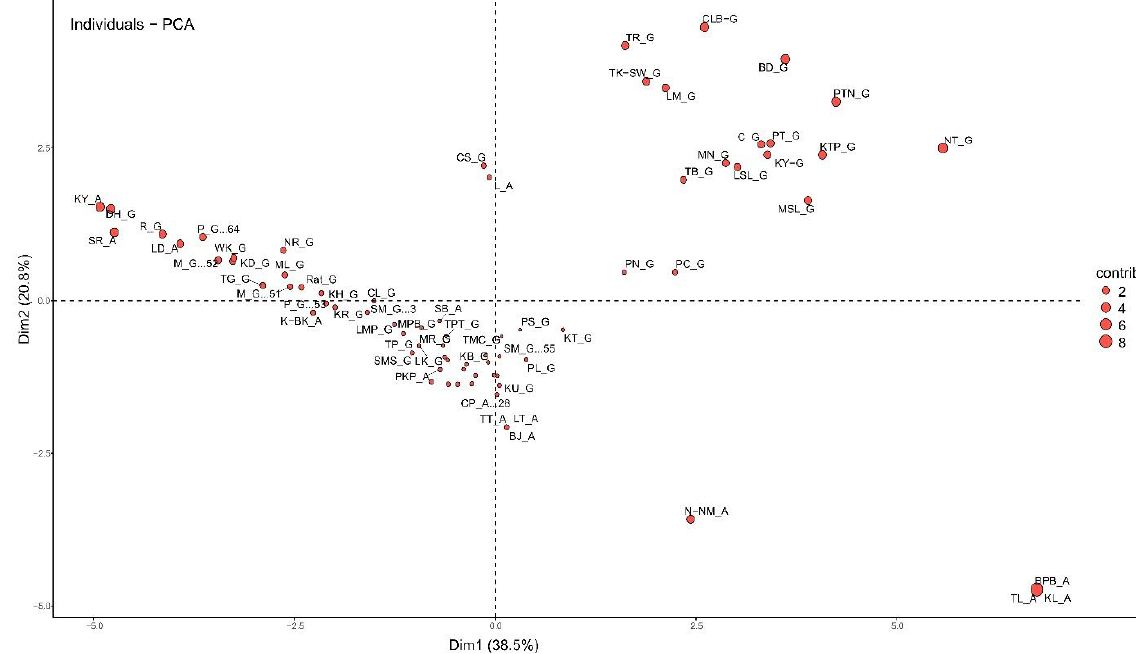
Figure 5. Principal-component-analysis biplot of the first two principal components (PC; 59.3% of the variance) of 82 seagrass meadows across Thailand based on multiple VU (17 threats) scores given for each site. Circle size indicates the percentage of contributions to PCA 1 and PCA 2. Letters A and G, after site code, indicate seagrass beds on the Andaman Sea coast and Gulf of Thailand coast, respectively.